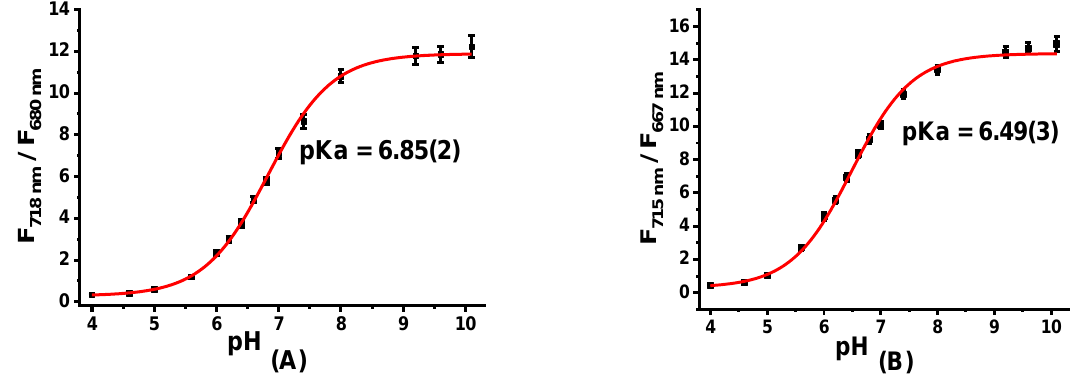
Figure 4. Fluorescence ratio changes of probes AH + ( A ) and BH + ( B ) versus pH changes from 4.0 to 10.1 under excitation at 630 nm.